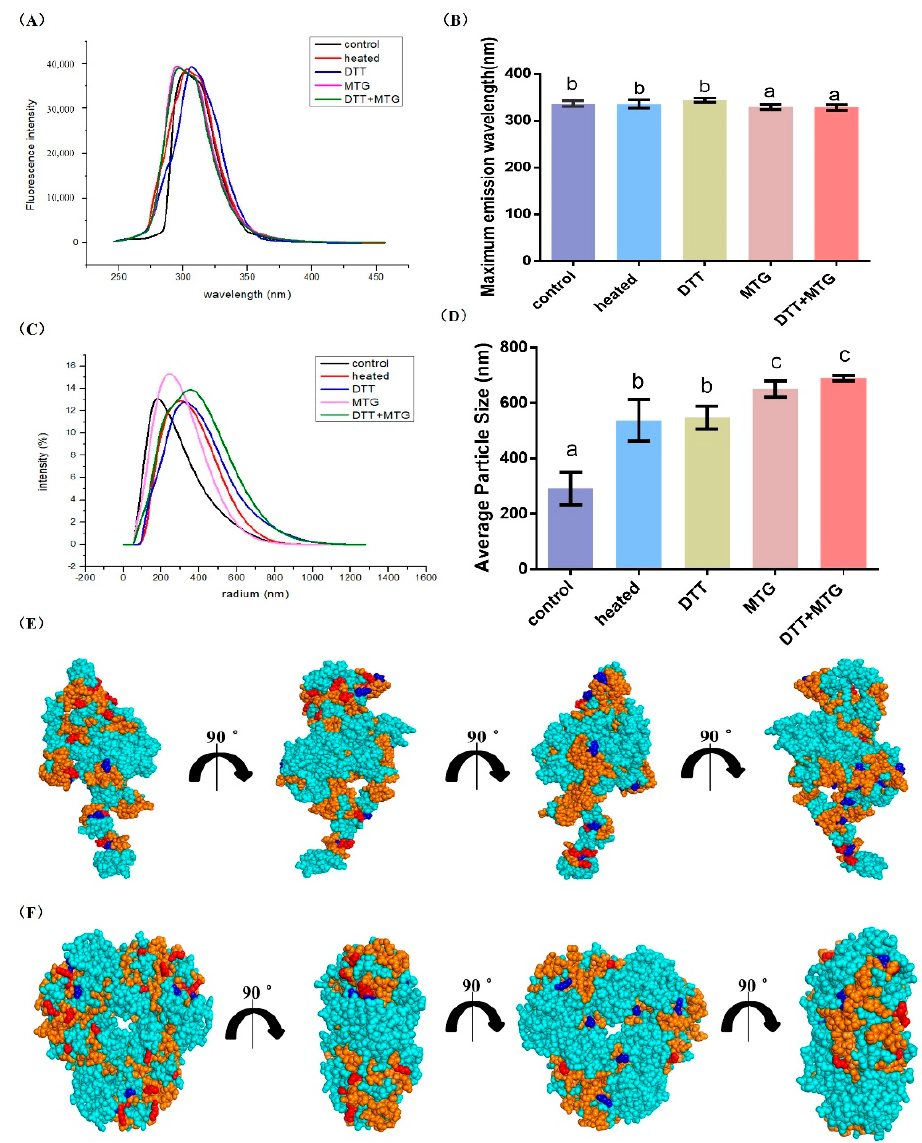
Figure 2. Structure features of rAra h 1 before and after modification. ( A ) Fluorescence spectrum plots, ( B ) Maximum emission wavelength, ( C ) Dynamic light scattering, and ( D ) Average particle size of protein samples. Control: non-processed rAra h 1, heated: rAra h 1 heated at 40 °C for 5 h, DTT: rAra h 1 reduced by DTT, microbial transglutaminase (MTG): rAra h 1 cross-linked by MTG, DTT + MTG: rAra h 1 reduced by DTT first, and then cross-linked by MTG. The letters a, b, and c represent for the significant difference between results. ( E , F ) are the globular presentations of linear epitopes as well as possible cross-linking sites on the monomer and trimer of rAra h 1, respectively. The epitopes are marked in orange, Lys and Gln located in the epitopes are marked in red and blue separately.